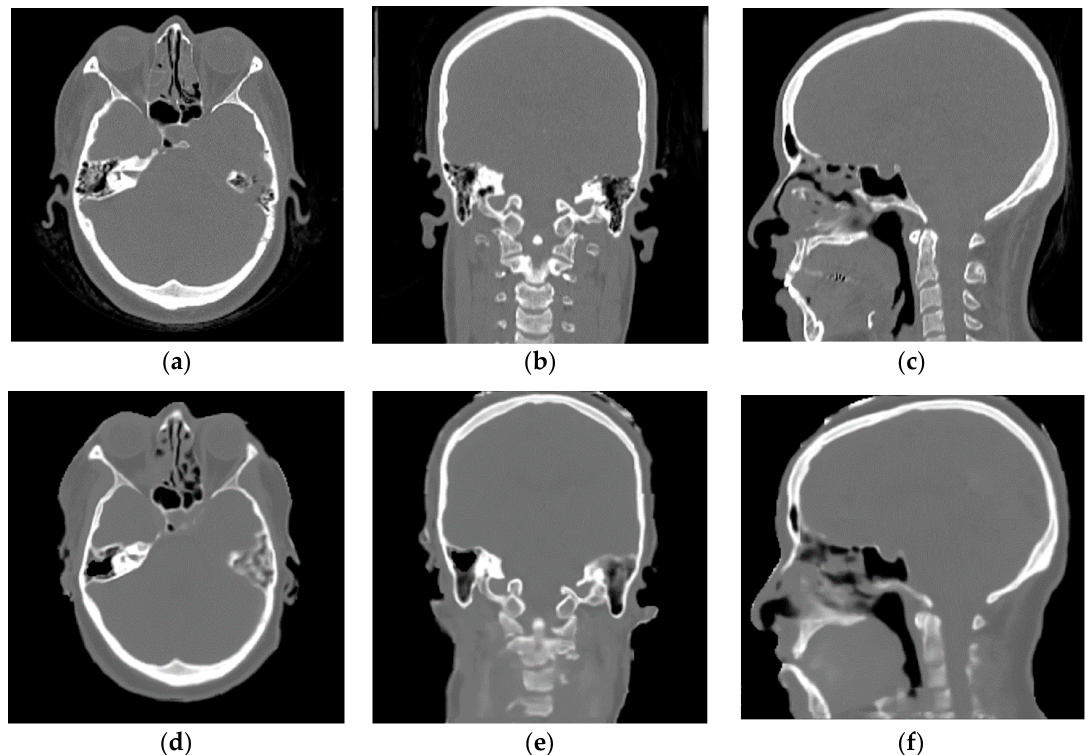
Figure 9. Axial, Coronal, and Sagittal CT images from Subject fct-test-02 showed in ( a – c ), respectively, and their corresponding computed pseudo-CT showed in ( d – f ). Bone delineation purpose looks quite good except for the neck region.